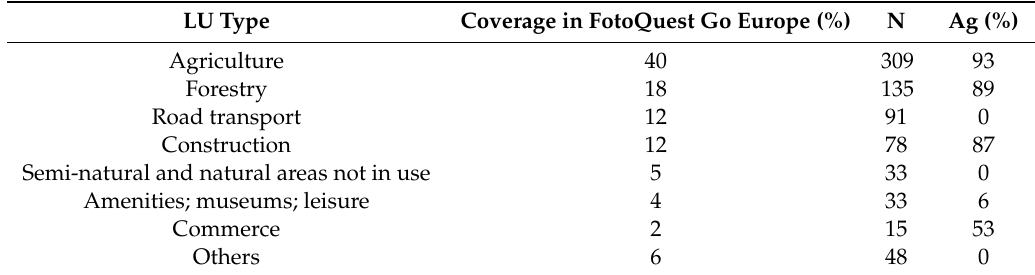
Table 7. Percent agreement by the main LU types. The data are sorted by the coverage of these areas in the FotoQuest Go Europe 2018 campaign in descending